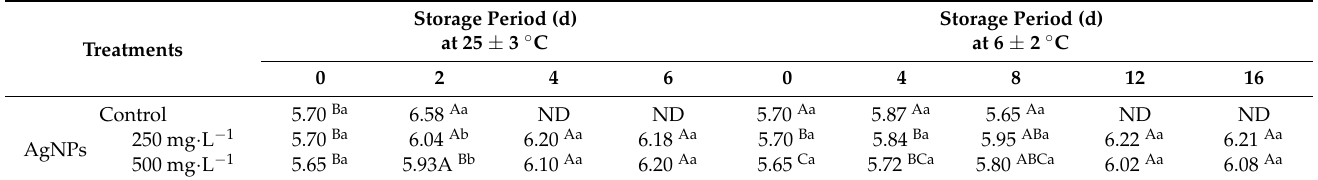
Table 4. TSS content of strawberry samples as a function of St-AgNPs coatings during